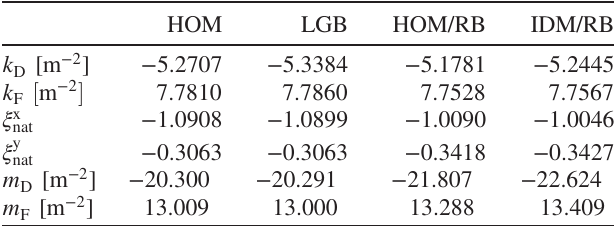
TABLE I. Focusing strengths k , natural chromaticities ξ and required integrated sextupole strengths m to compensate chromaticities to zero, for four example cells.